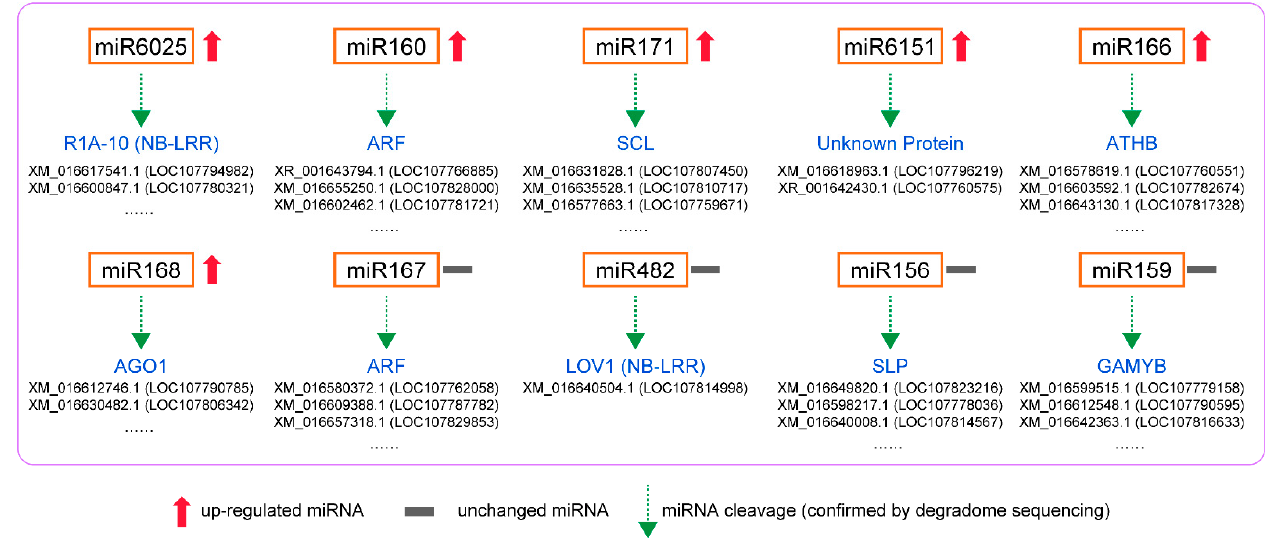
Figure 6. Potential regulatory modules of miRNAs confirmed by degradome sequencing in N. tabacum infested by whiteflies.